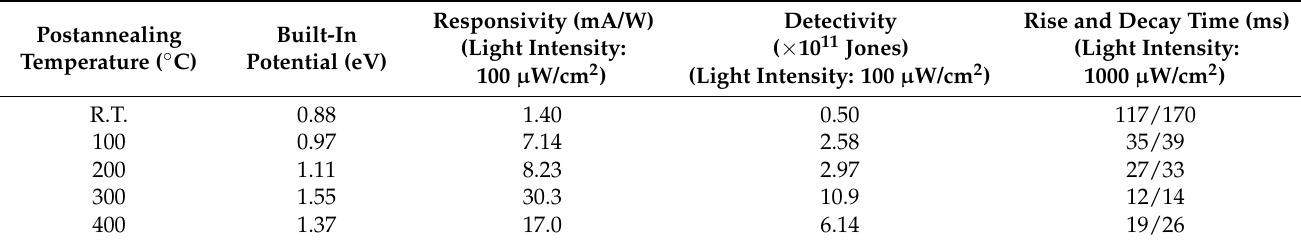
Table 3. Postannealing temperature-dependent values of built-in potential of devices. Photoresponse parameters of CuO/ β -Ga 2 O 3 heterojunction as a function of postannealing temperature measured at zero bias under solar-blind UV light.